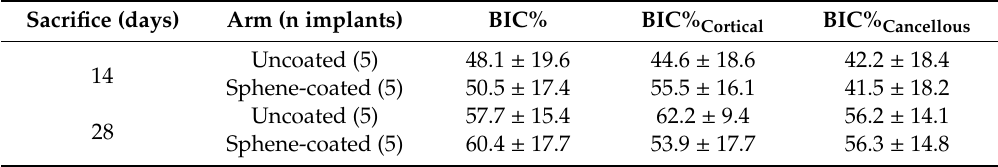
Table 5. BIC%, BIC% Cortical and BIC% Cancellous values in the uncoated and the sphene-coated arms. Sacrifice